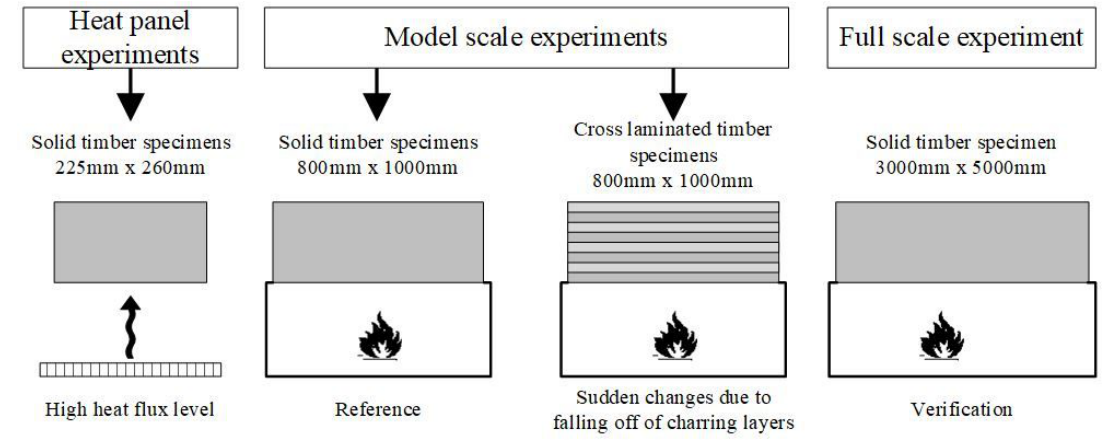
Figure 3: Experimental setups performed in the presented